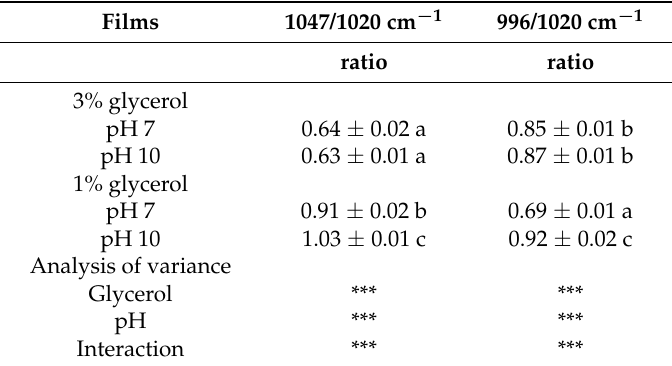
Table 4. FTIR ratios of chickpea flour